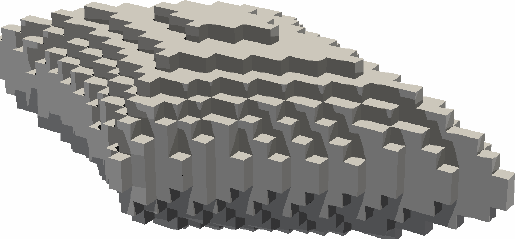
Figure 3. Voxel representation of the particle with the shortest half-axis length of 9.1 × 10 − 5 m for N = 20.